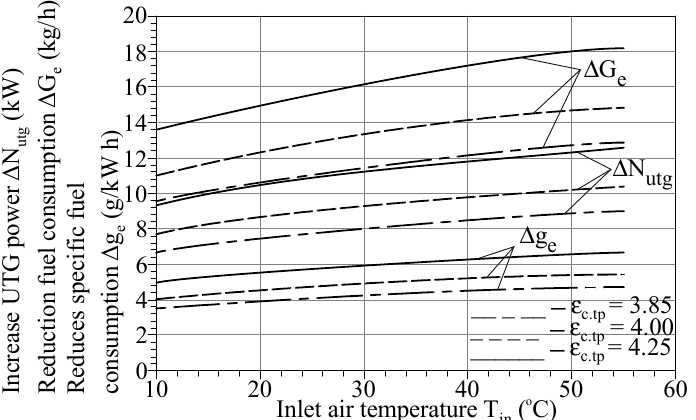
Figure 25. Dependences of the increase in UTG power Δ N utg ; reduction in fuel consumption, Δ G e , reduces the specific fuel consumption, Δ g e , at different total pressure increase, ε c . tp , on the inlet air temperature, T in .